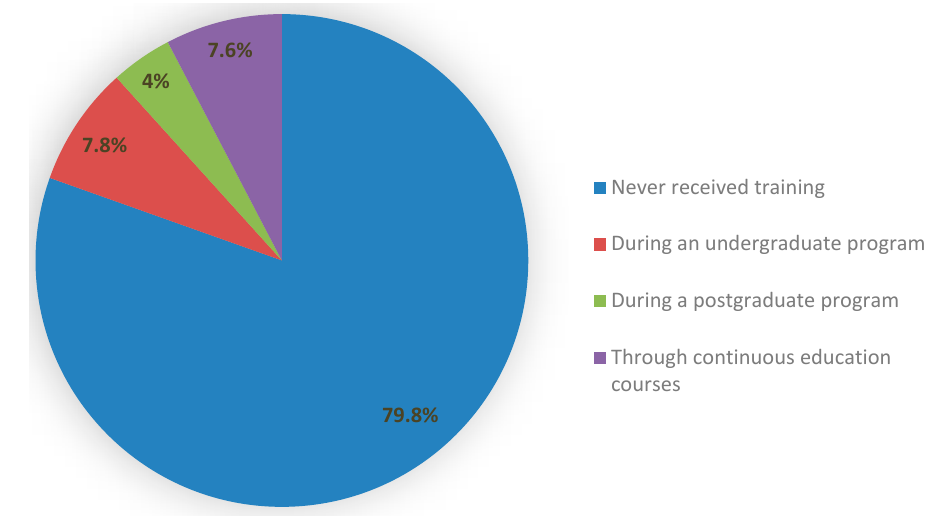
Figure 2. Participants’ responses regarding training received on teledentistry. Table 4. Responses of participants to training-related questions based on qualification and clinical experience ( n = 603).